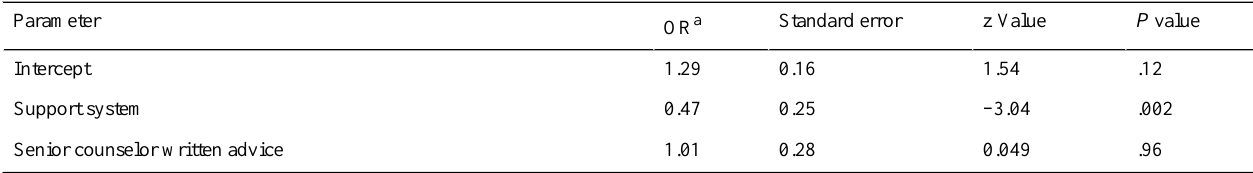
Table 2. Fixed effect of the expert label for the model of support system and senior counselor written